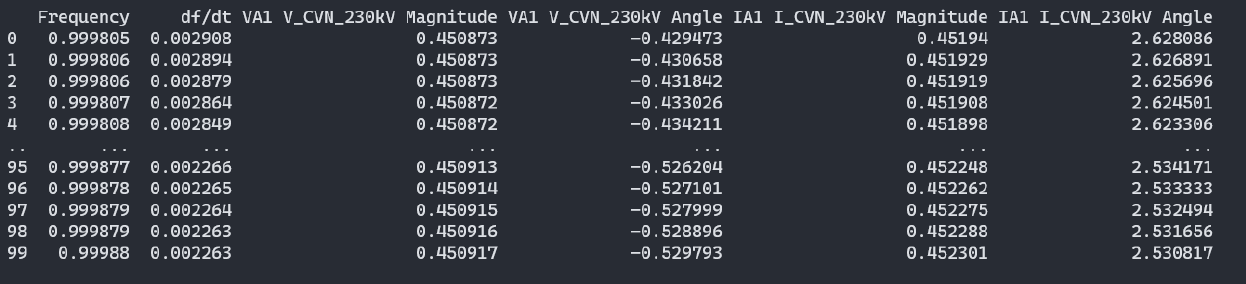
Figure 3. Data of frequency, rate of change of frequency (df/dt), magnitude and angle of voltage and current of phase A, normalized.